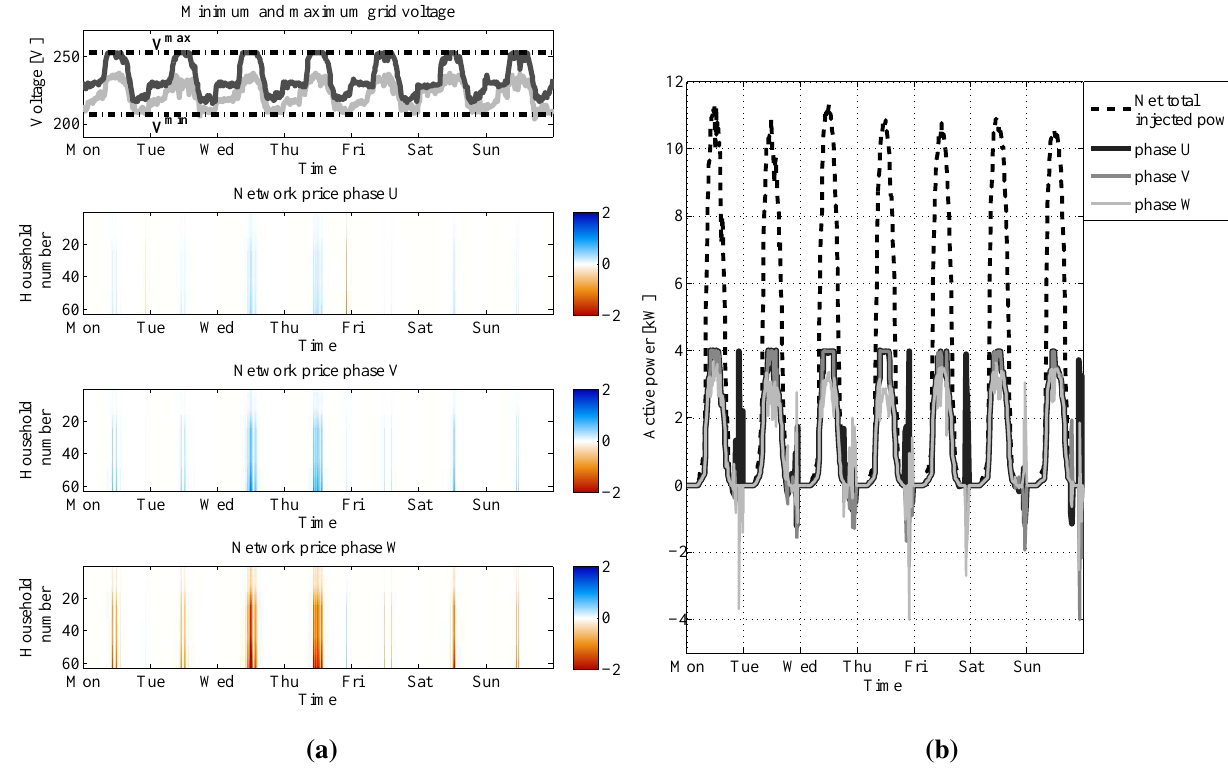
Figure 10. The maximum and minimum phase voltage that occurs in the control nodes and the network price at each node for active power curtailment during a sunny week in the case of active power curtailment, reactive voltage control and arbitrage (a) and the total net injected power by the two balancing inverters and the total injection into each of the phases during this week (b)